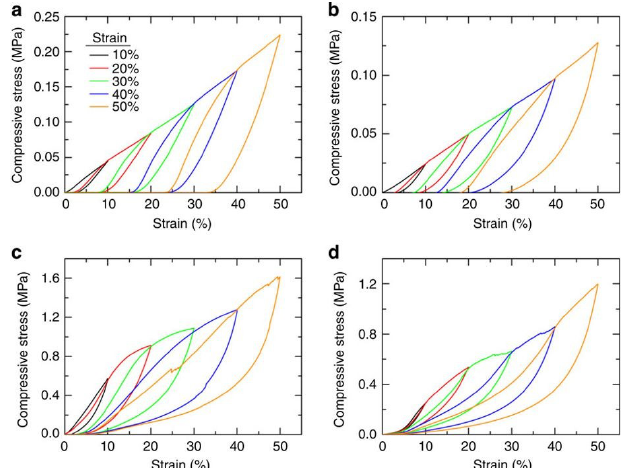
Figure 10. Reversible compressibility of various graphene aerogels created via DIW. Image ( a ) shows the behavior of a bulk graphene aerogel (31 mg cm − 3 ), ( b ) 3D-printed graphene aerogel (16 mg cm − 3 ), ( c ) bulk graphene aerogel (123 mg cm − 3 ), and ( d ) 3D-printed graphene aerogel (53 mg cm − 3 ) using resorcinol-formaldehyde. Reprinted from [130] under open access